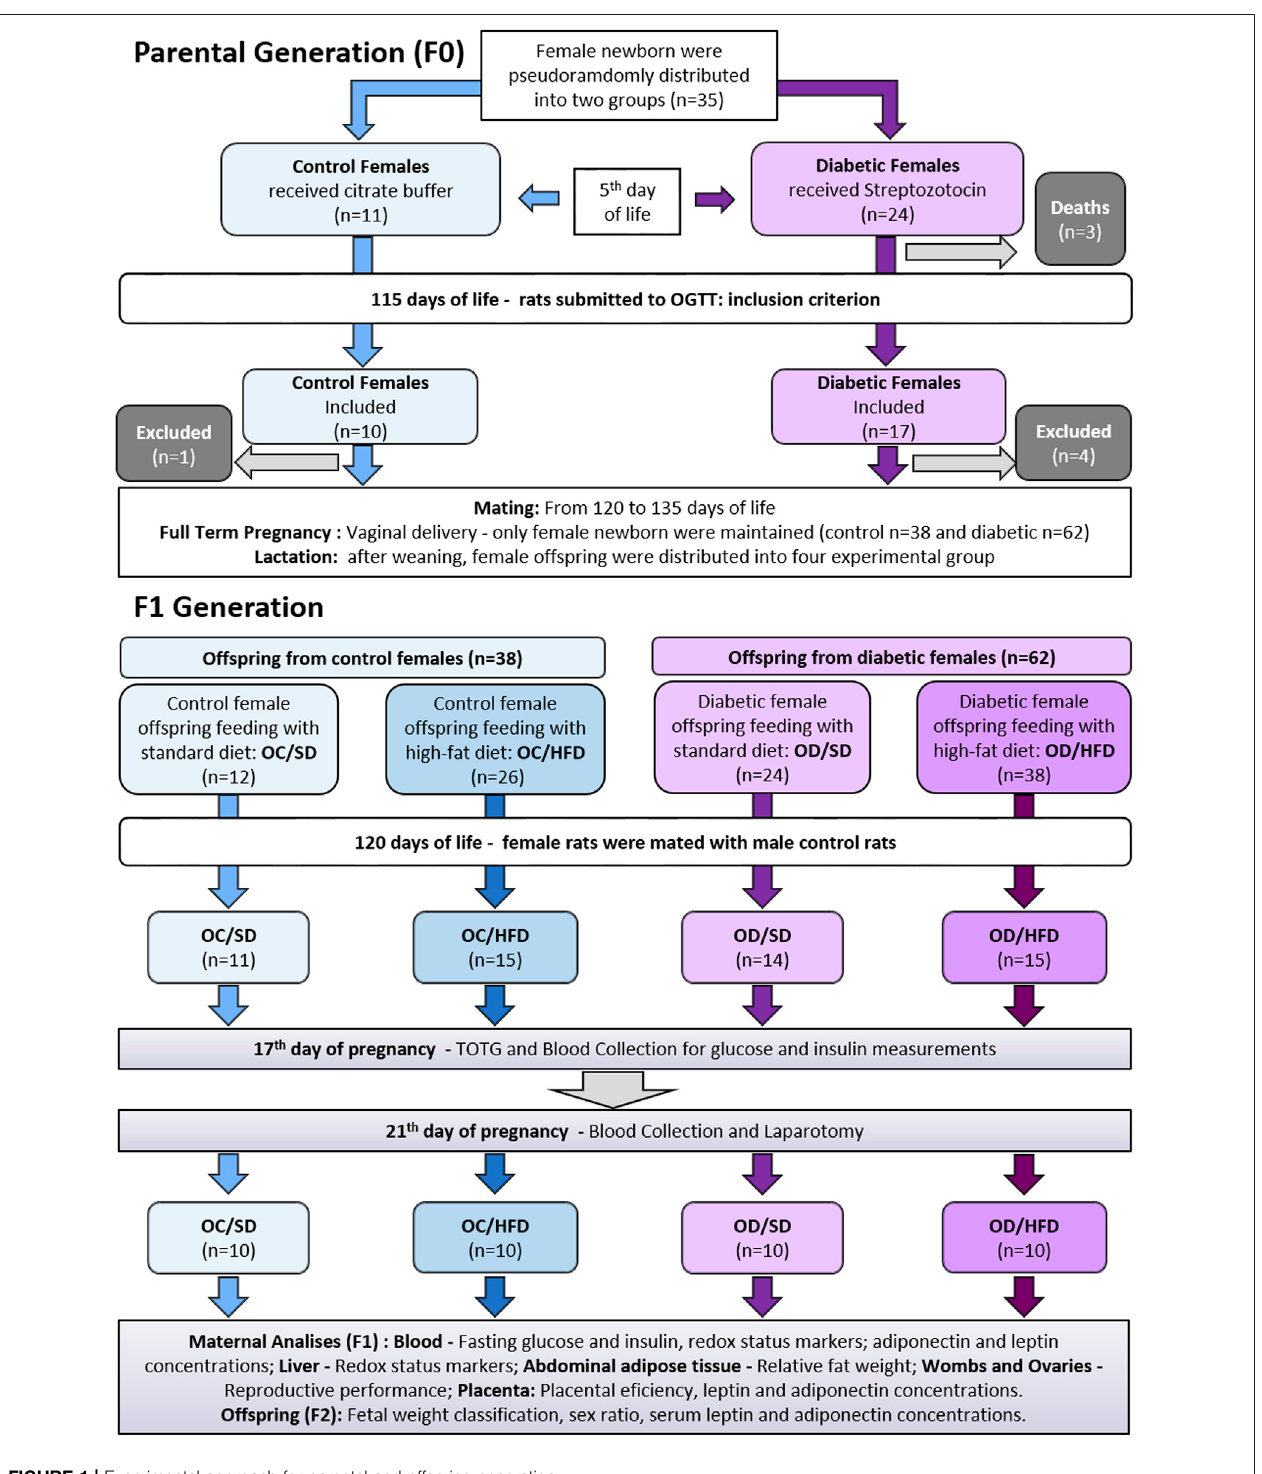
FIGURE 1 | Experimental approach for parental and offspring generation.